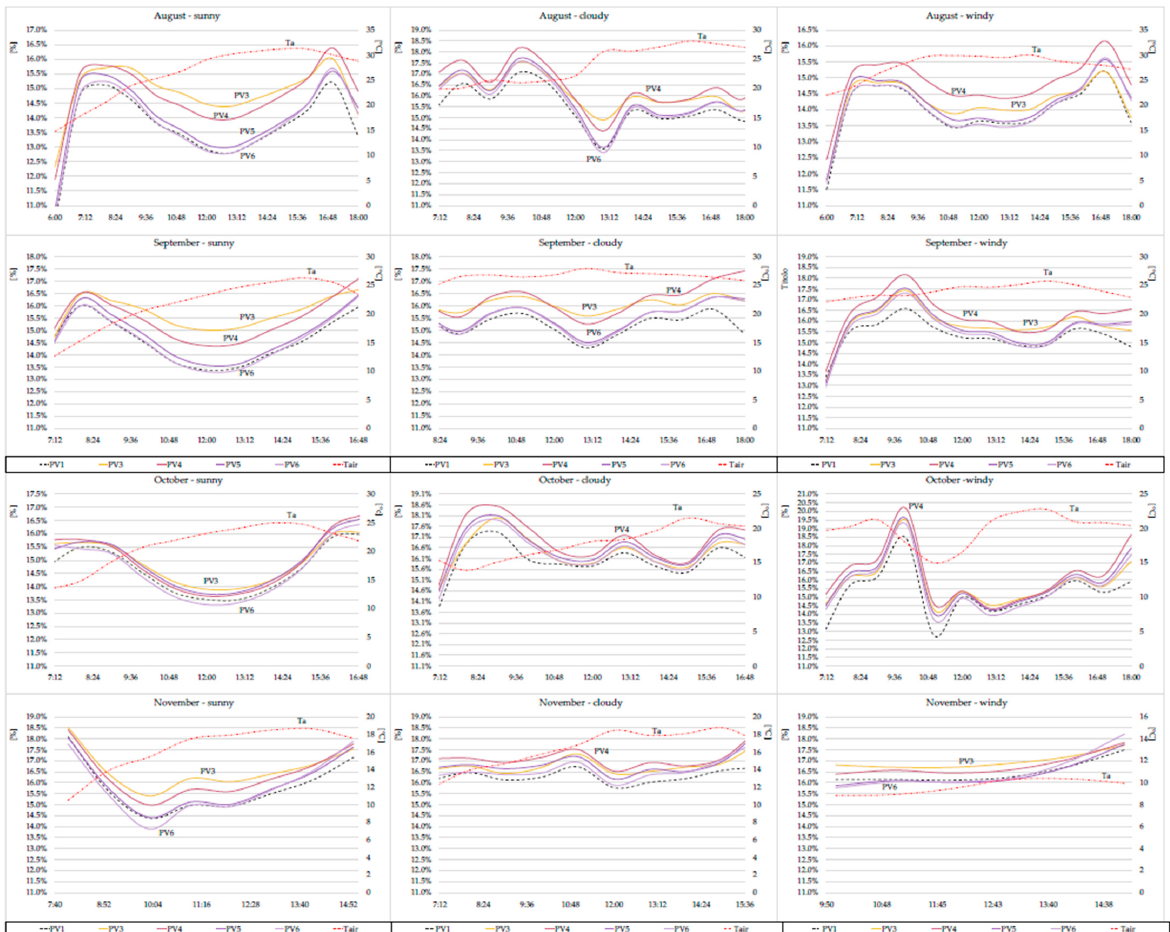
Figure 5. Electric efficiency of the reference module and the four modules equipped with cooling systems in three different climatic conditions for the months of August, September, October and November 2016.